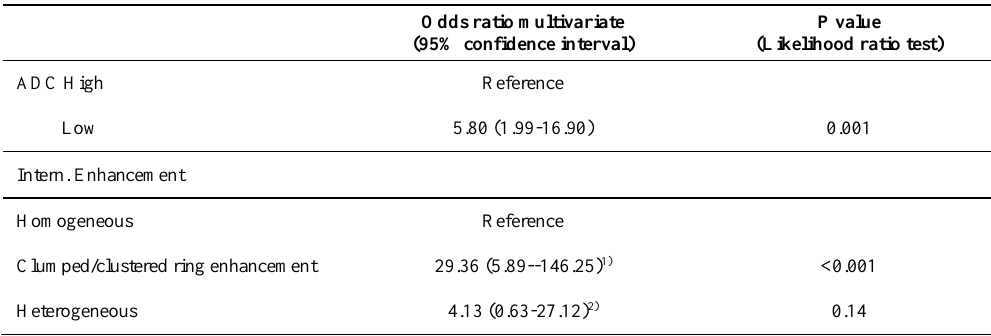
Table 4. Multivariate analysis results